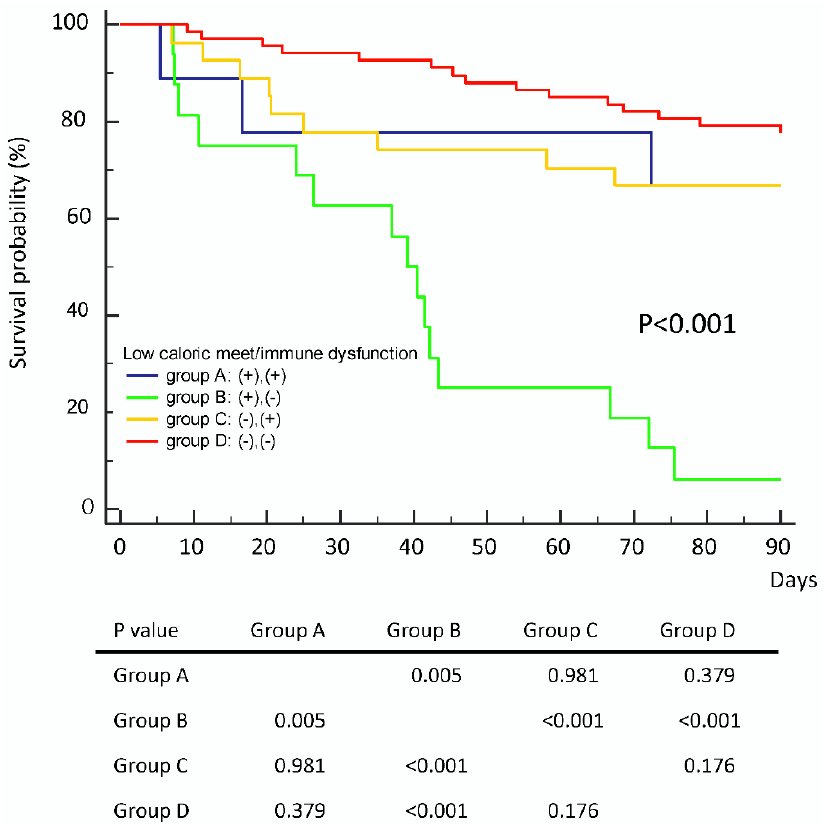
Figure 3. Impact of day 7 caloric meet on survival outcome in patients with or without immune dysfunction. Patients with higher day 7 caloric meet and normal immune status had the best prognosis. Patients with lower day 7 caloric meet and normal immune status had a worse prognosis.